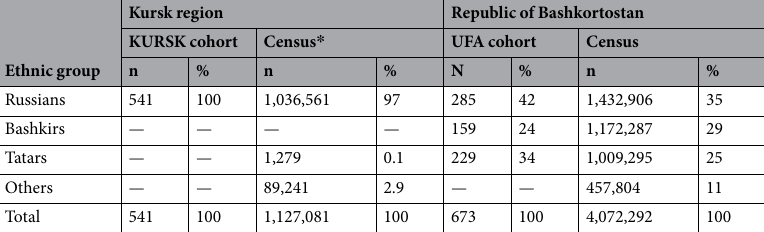
Table 1. Comparison of study populations. * Official website of the Russian Census 20 .